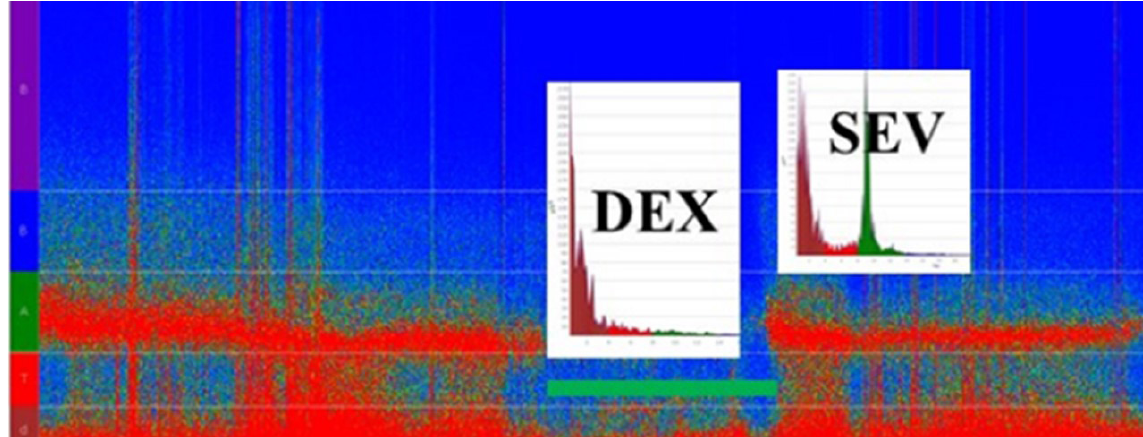
Fig. 3 - Spectrogram of a frontal channels (Fz-F8) recording during anesthesia for atrial septal defect correction of a seven-year-old patient maintained with remifentanil (0.1-0.3 µg/kg/min), dexmedetomidine (DEX) (1 µg/kg/h), and sevoflurane (SEV) (expiratory concentrations: 0.5- 2.2 %). DEX corresponded to a period when no sevoflurane was administered, and a typical DEX-electroencephalogram (EEG) signature (delta frequency band dominance) could be seen. SEV (2.2 %) was given after weaning off the cardiopulmonary bypass (green line), producing the sevoflurane EEG signature (delta and alpha frequency bands